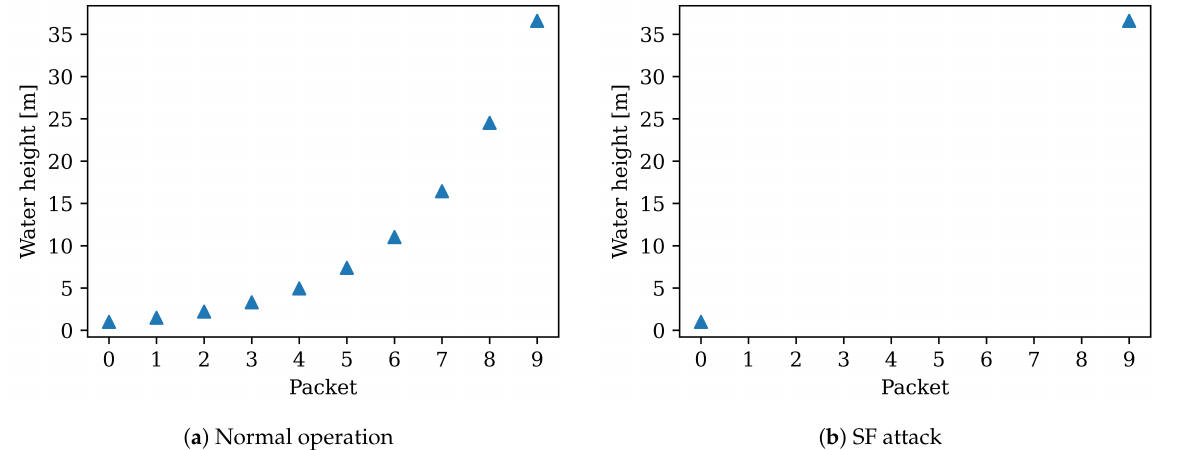
Figure 10. ( a ) Water height values (indicated by triangles) gathered from end-device with no attack present, ( b ) water height values with a Selective Forwarding Attack present.